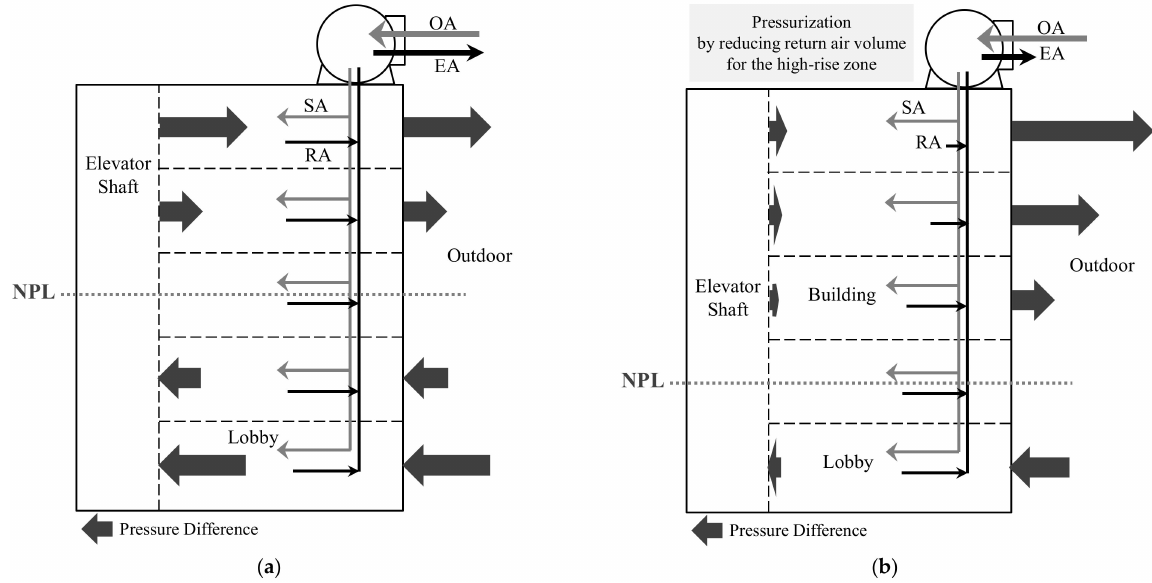
Figure 1. Pressure distribution when pressurizing the high-rise zone by reducing exhaust air volume of an HVAC system. ( a ) Before pressurization; ( b ) after